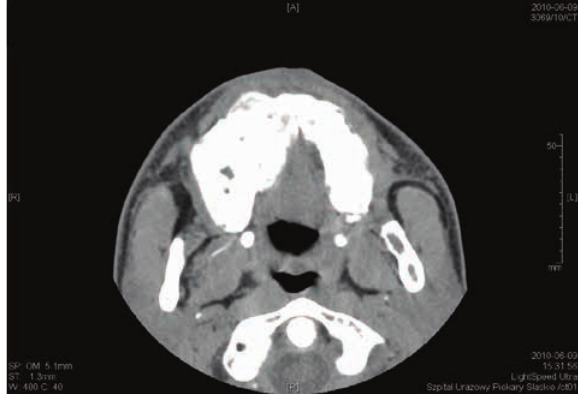
Figure 4b: Patient K. M, aged 19. CT scan. Cross section on horizon-